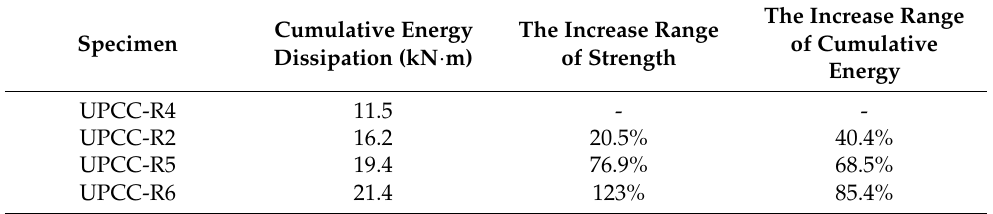
Figure 25. Cumulative energy dissipation curves under different steel yield strength of EREDL. Table 11. Final cumulative energy consumption of each specimen and the increase range of specimen strength and cumulative energy.